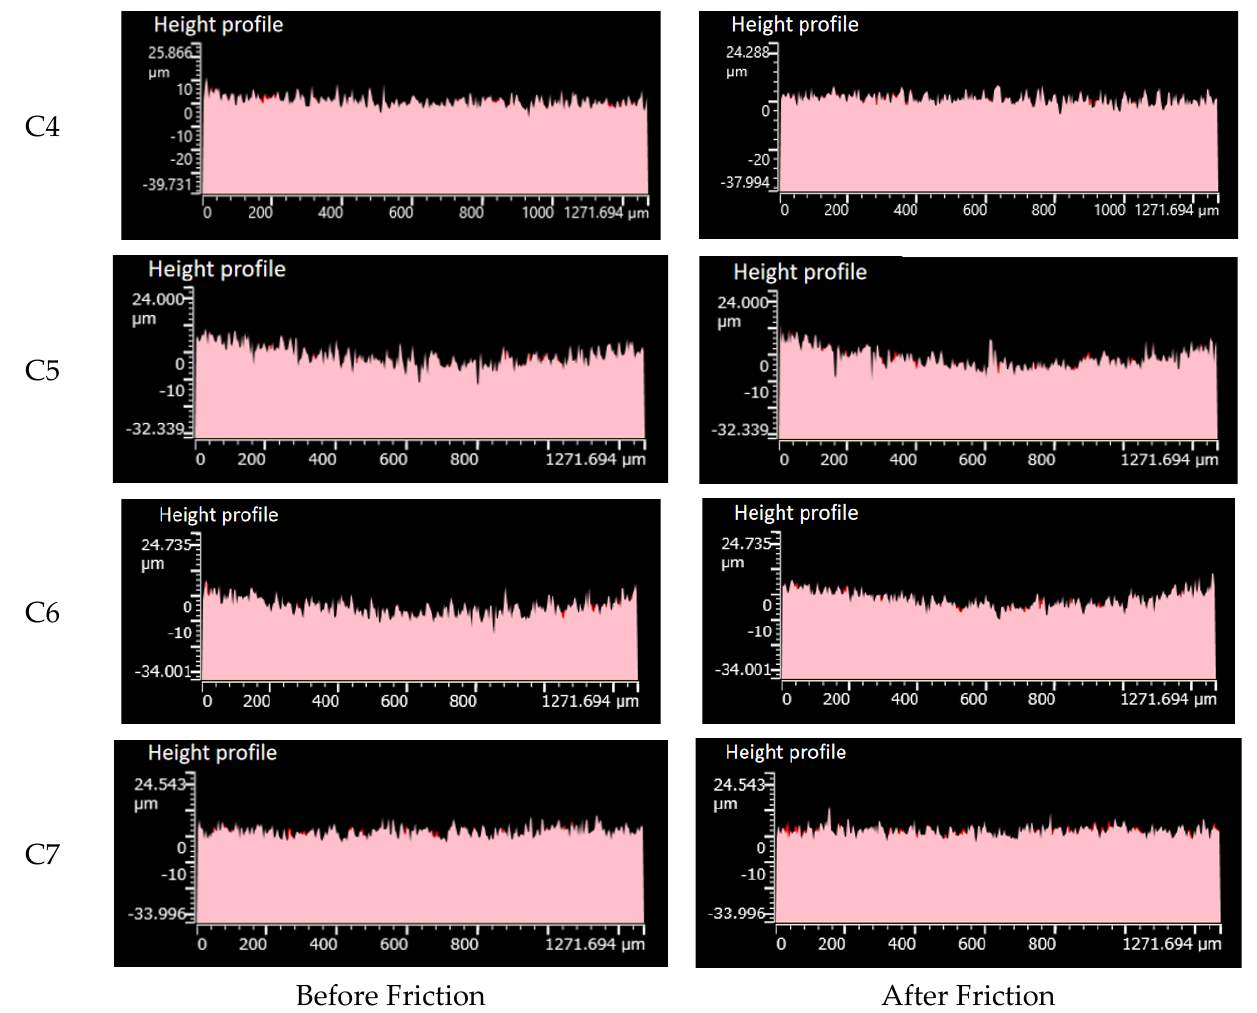
Figure 10. Metal height profile. ( C1 – C7 ) are the height profiles of 7 groups of metal before and after friction.